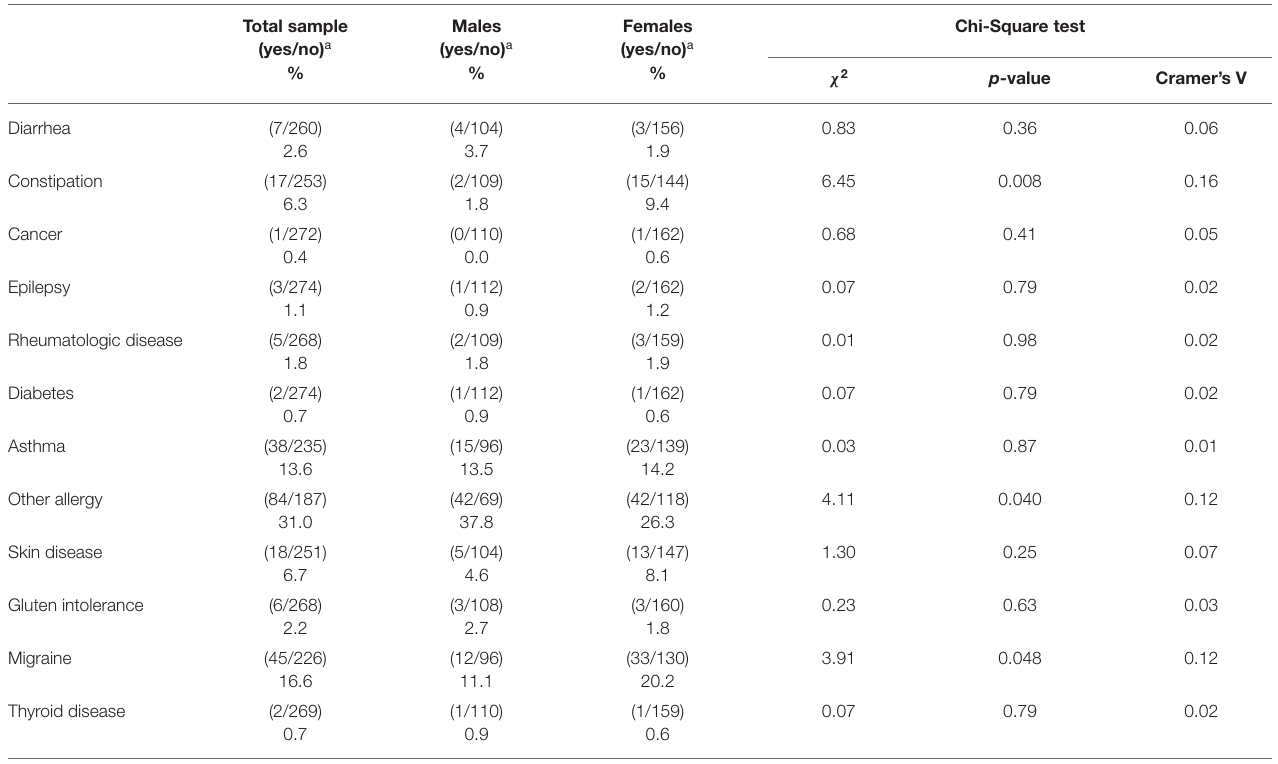
TABLE 2 | Prevalence of defined somatic symptoms and diseases in a sample of Swedish students ( N =